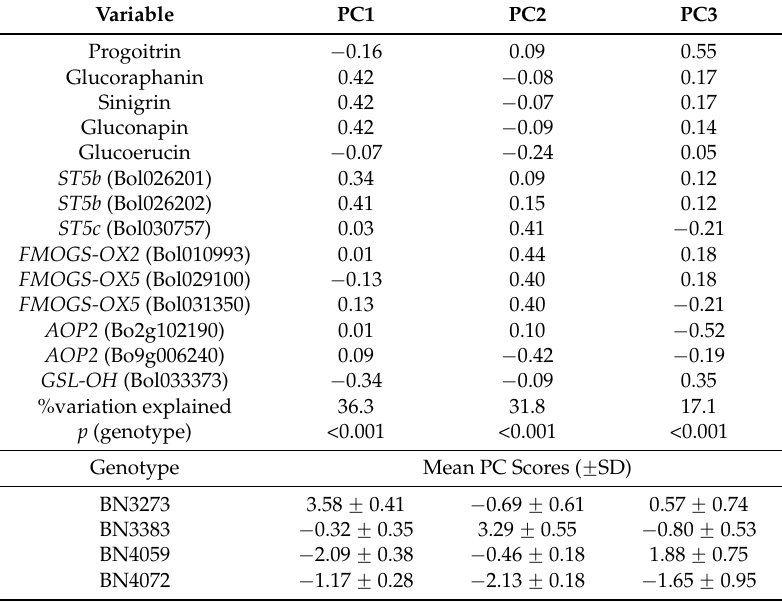
Table 3. Principal component analysis for aliphatic glucosinolate contents and the relative expression level of the biosynthesis-related genes in four cabbage lines of B. oleracea. PC, principal component; p , statistical significance; SD, standard